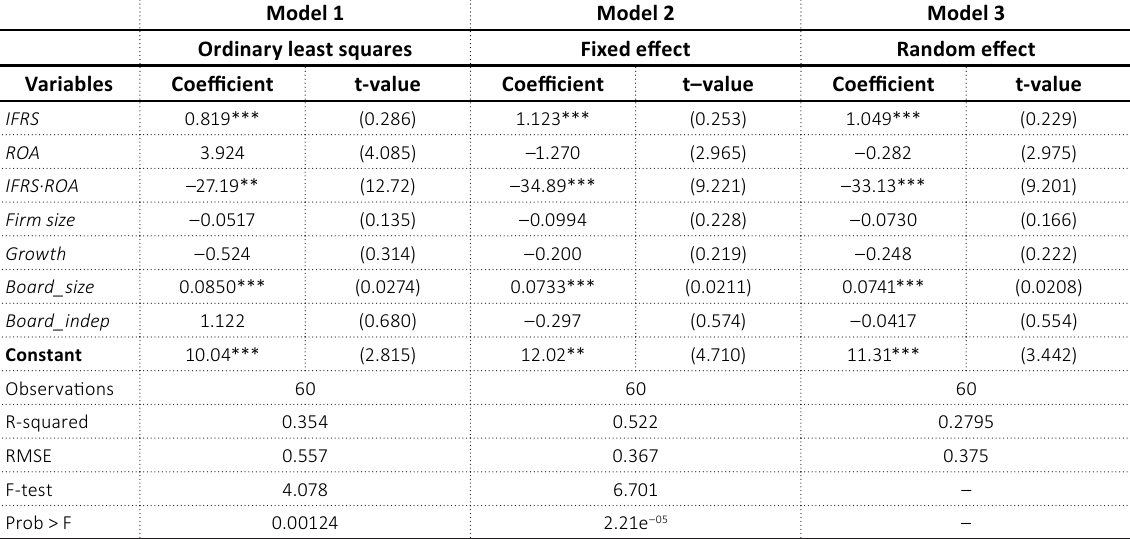
Source: Authors’ survey